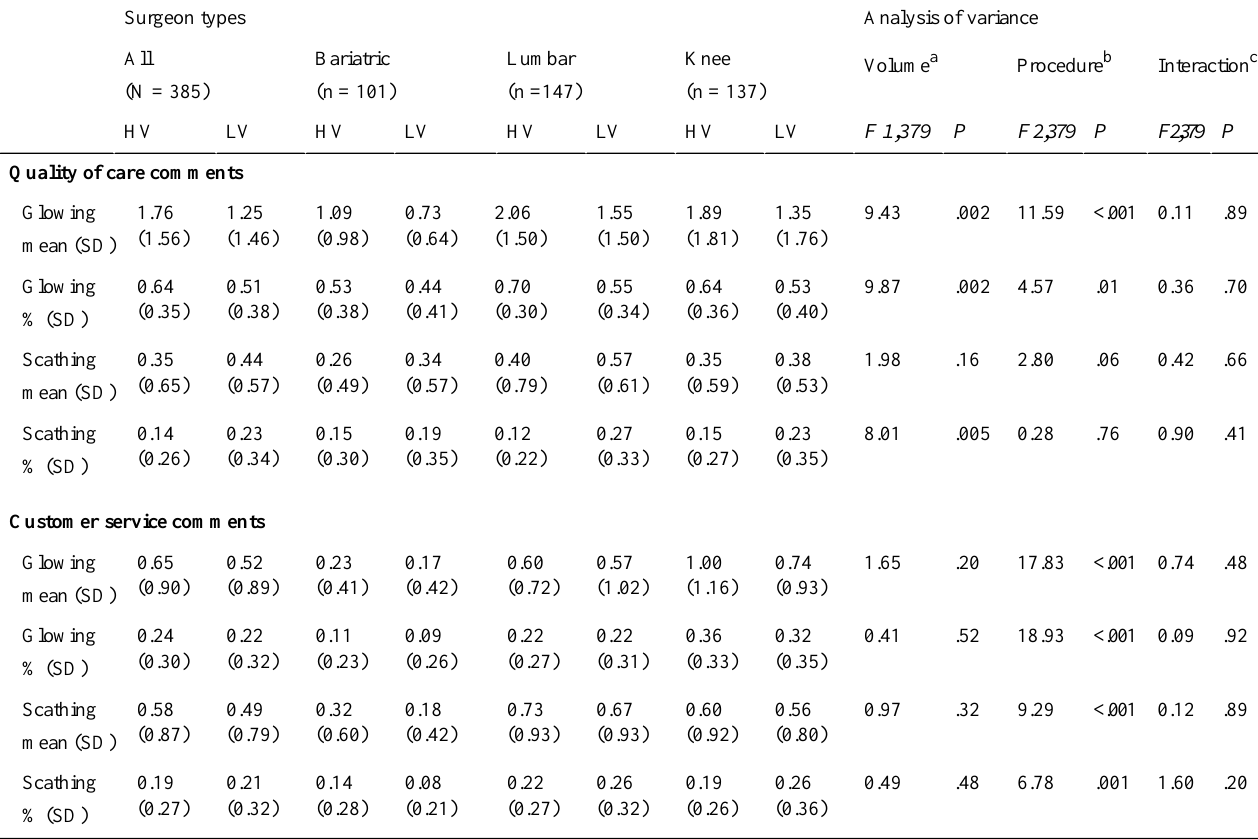
Table 7. Analysis of scathing and glowing comments for high- and low-volume surgeons.